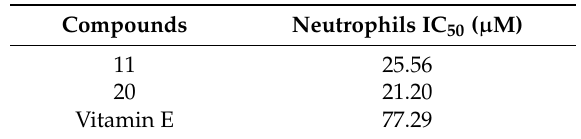
Table 3. Antioxidant activity data of compounds 11 and 20 .